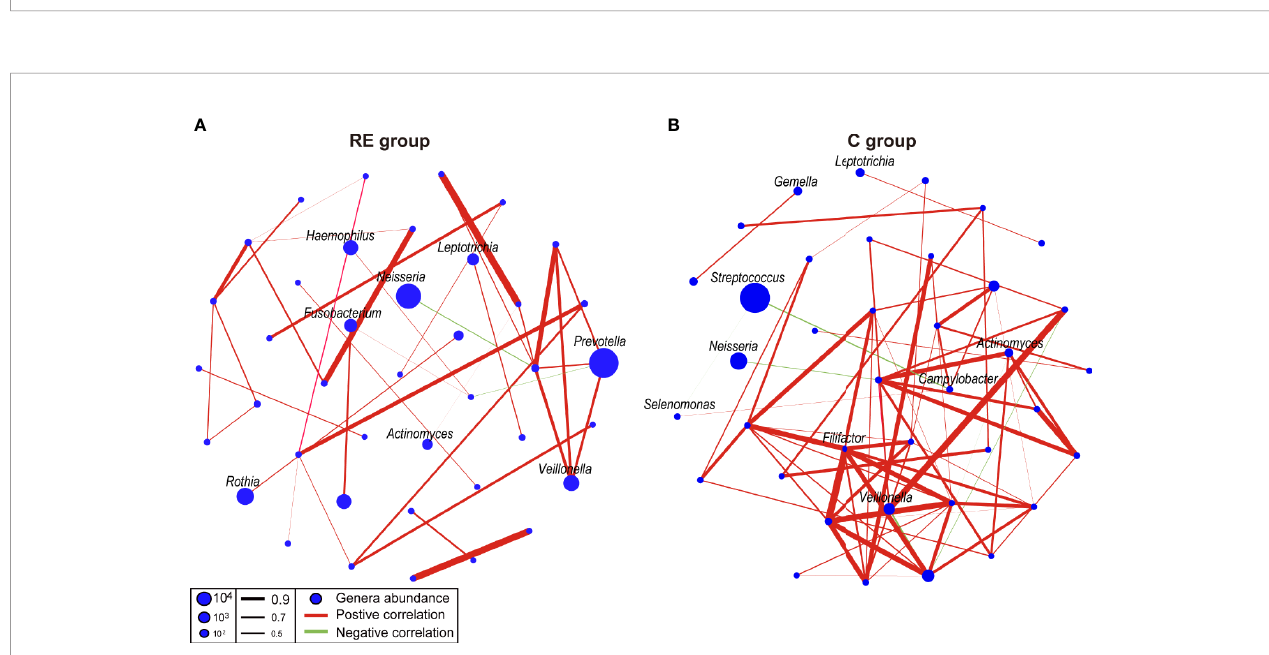
FIGURE 2 | Comparison of bacterial abundance between the re fl ux esophagitis and the healthy groups. The abundance of Bacteroidetes in the RE group was higher, while the abundance of Firmicutes in the C group was higher, ** P < 0.01 (A, B) . LEfSe analysis results of the RE and C groups (C) .